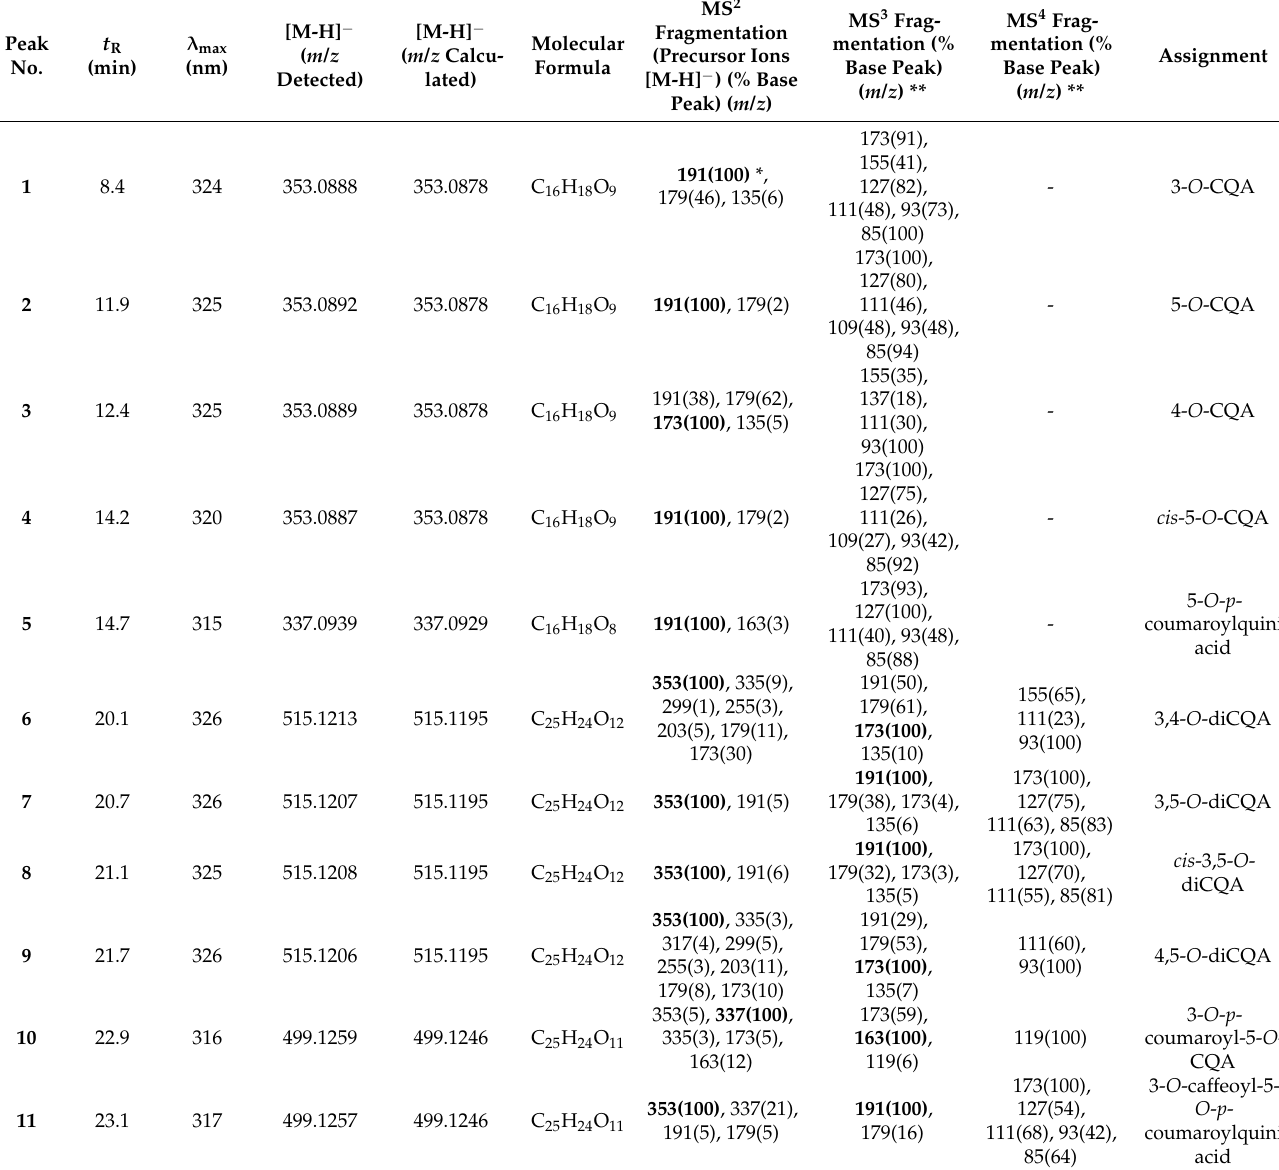
Table 1. List of caffeoyl- and coumaroylquinic acid derivatives identified in methanol extracts of Sr-L1 callus culture and S. radiata leaves by their retention times and UV and MS data.